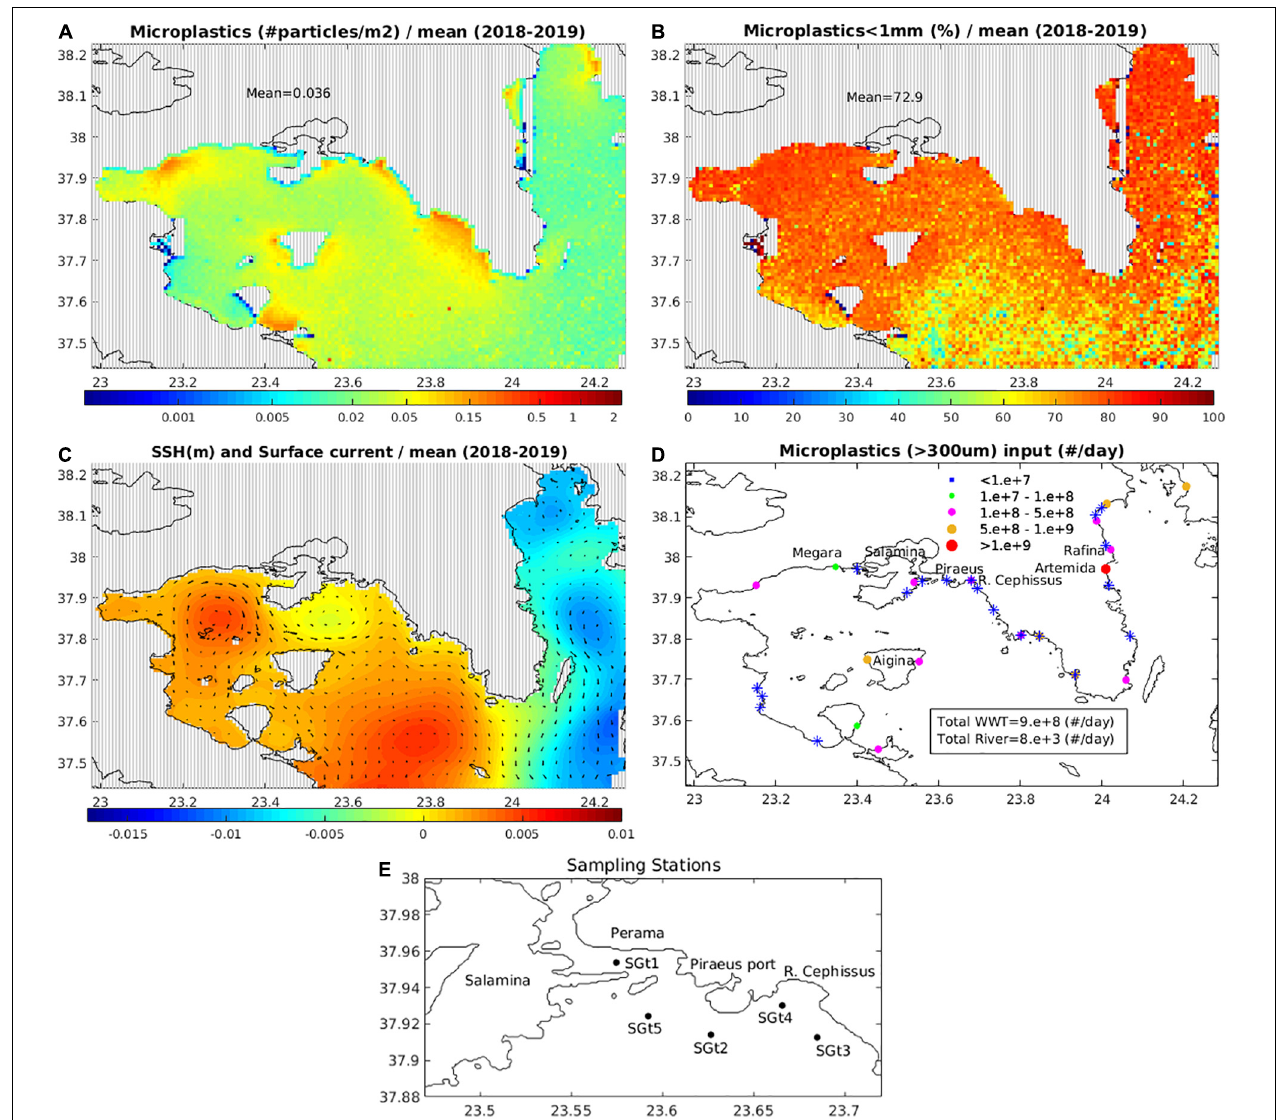
FIGURE 3 | Mean (2018–2019) simulated (A) microplastics concentration (items/m 2 ) (B) microplastics < 1 mm (%), (C) surface current and sea surface height (m) and (D) sources of microplastics (items/day) from cities wastewater discharge and river runoff, (E) sampling stations in Saronikos